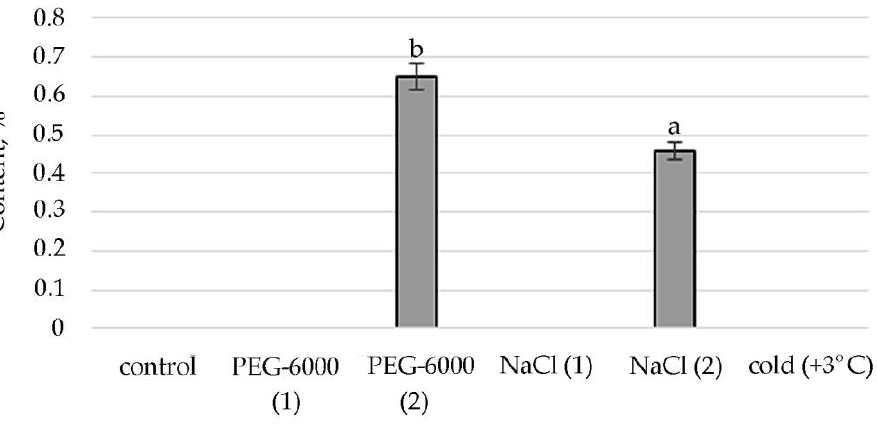
Figure 6. Change in content of γ -tocopherol in S. hybridum under stress conditions. Values presented are means (±SD). Different letters above the bars represent significant differences at p ≤ 0.05, n = 3 plants in each of 3 replicates for all treatments.